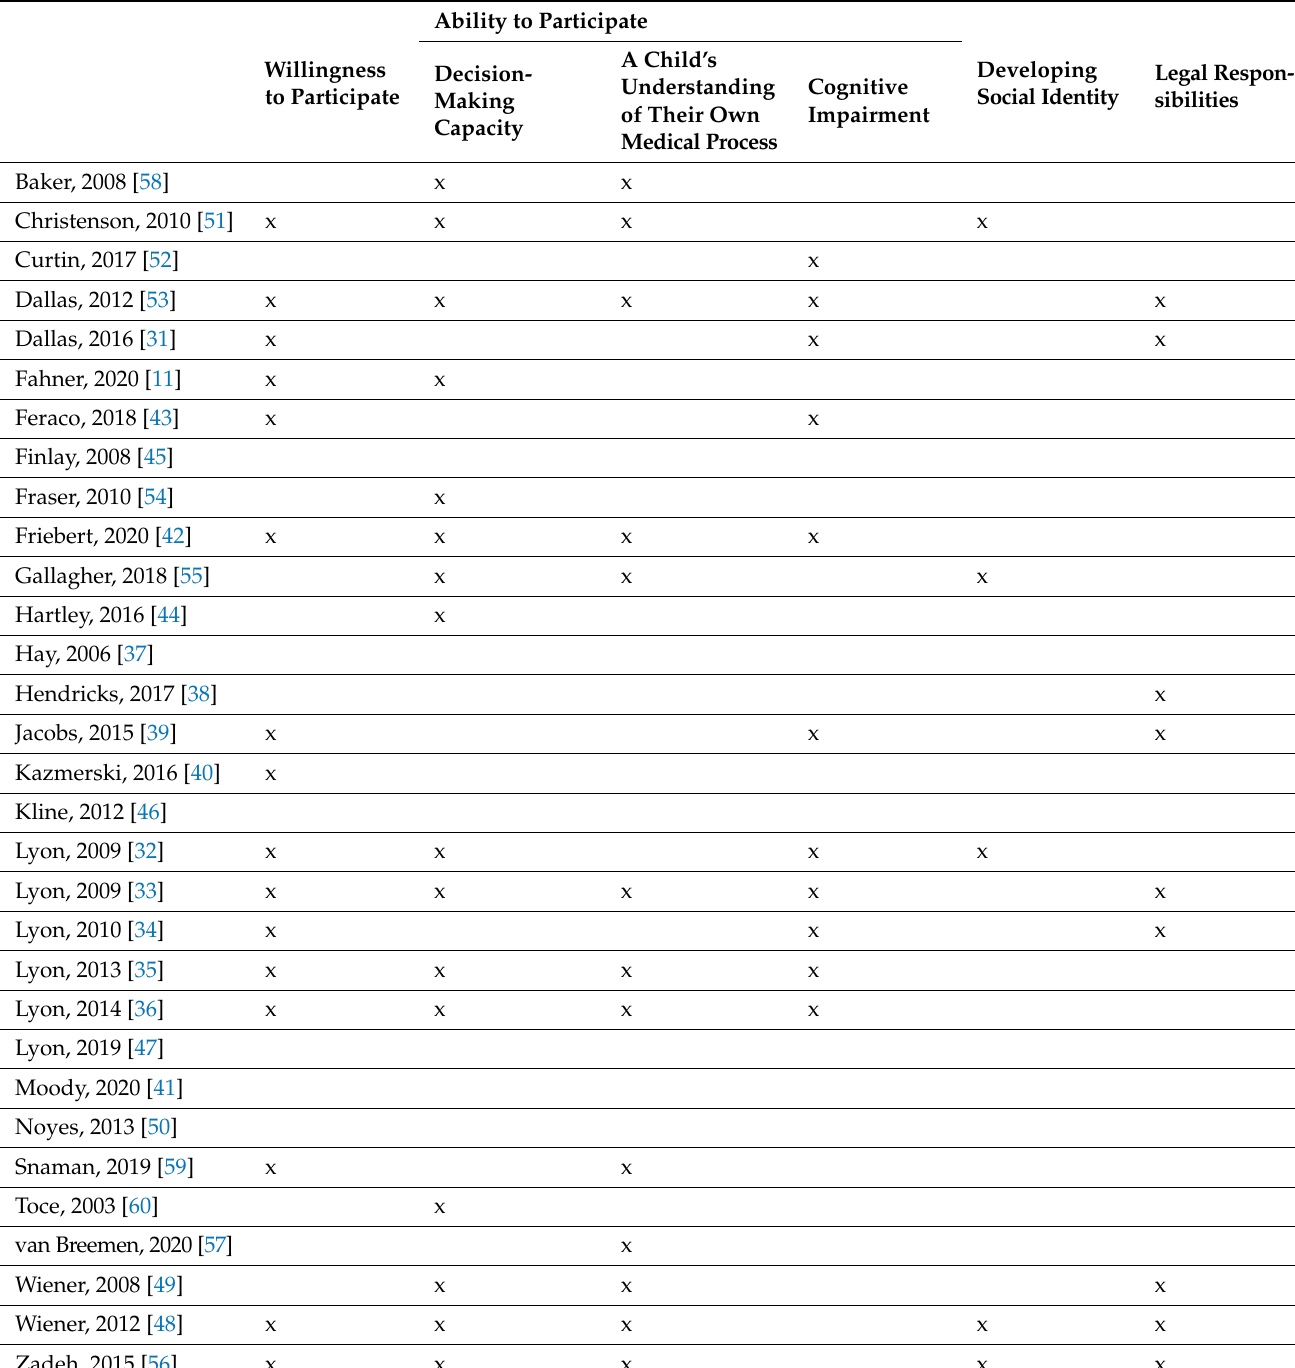
Table 9. Factors related to age